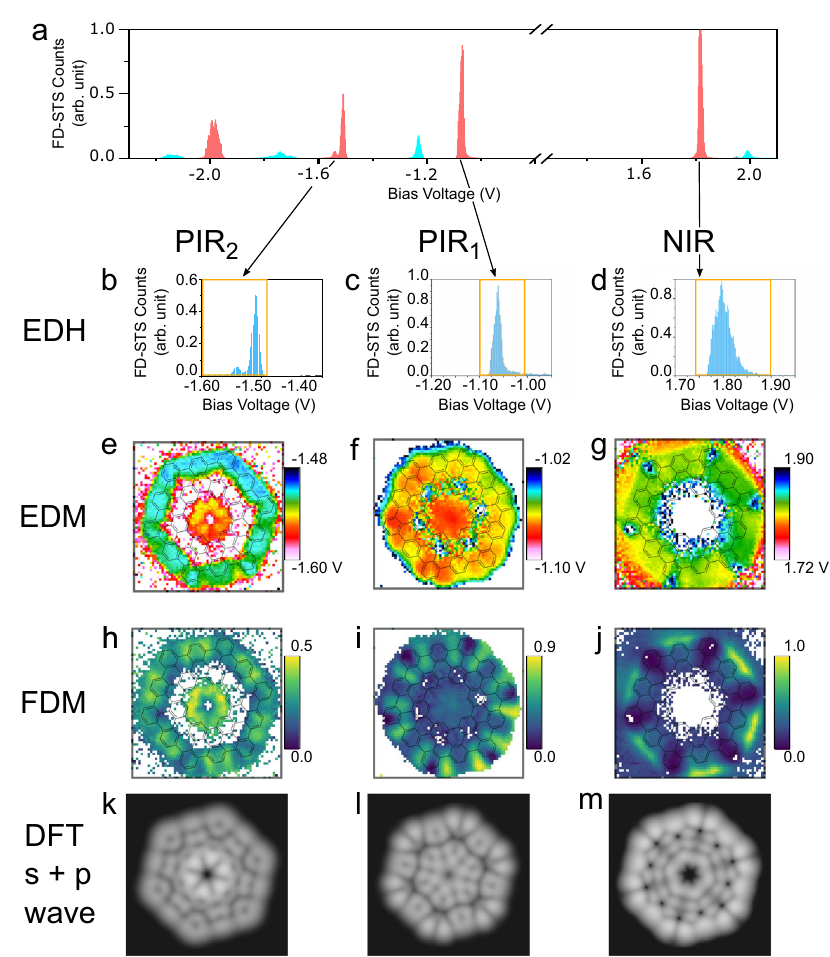
Fig. 6 FD-STS with a CO tip and calculated gas-phase molecular orbitals of C108. a C108/Au(111) histogram of detected peaks (energy distribution histogram EDH, red) and vibronic replicas (cyan) produced by statistical analysis of a 64 × 64 grid of d I /d V spectra measured over the molecule. b – d Energy distribution histograms (EDH) of the same resonances. The yellow boxes indicate the selected energy ranges chosen for the FDMs and EDMs in e – g and h – j respectively. e – g Energy distribution maps (EDM) of PIR 2 , PIR 1 and NIR (from left to right). h – j Feature distribution maps (FDM) of PIR 2 , PIR 1 and NIR (from left to right). k – m Visualization of the of the molecular wavefunctions as calculated by DFT using an sp-wave mixed tip at the resonance energies V PIR2 = − 1.52 V, V PIR1 = − 1.06 V, and V NIR = 1.8 V. EDMs and FDMs overlaid with the chemical structure of the C108. Image sizes are 2.4 × 2.4 nm 2